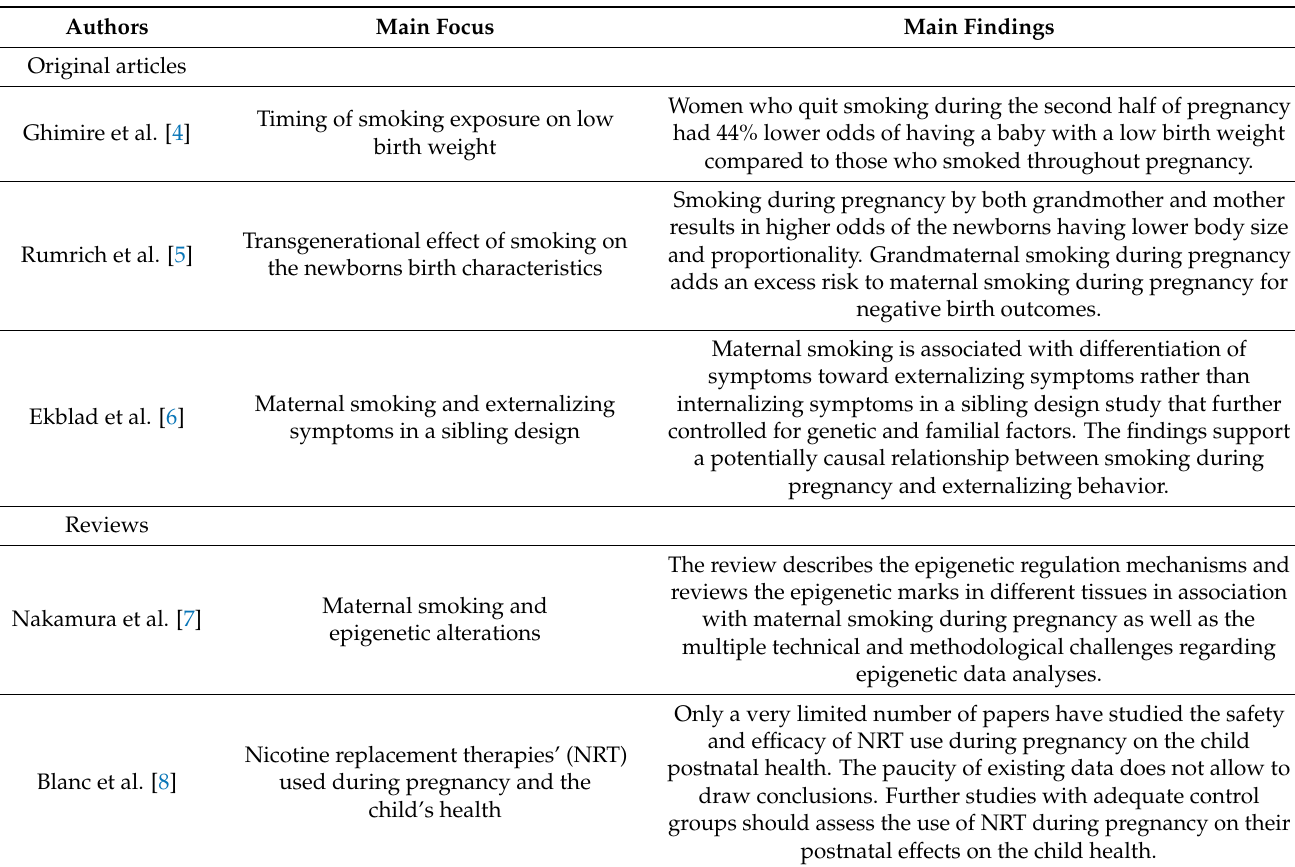
Table 1. Main findings of the articles published in this Special